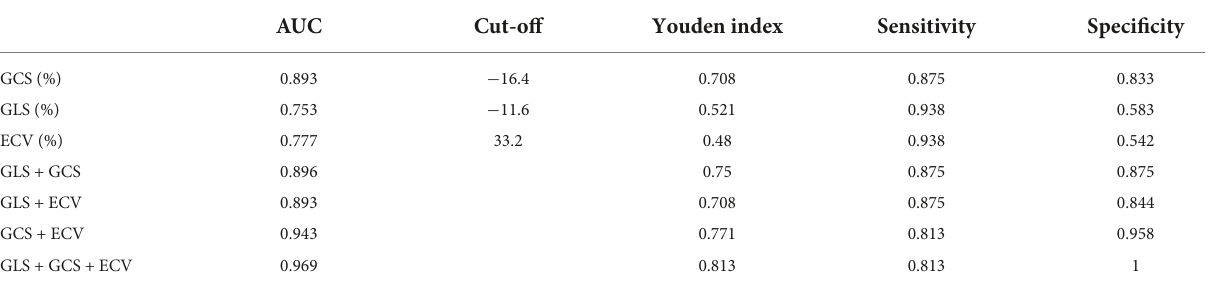
TABLE 5 The diagnostic value of cardiovascular magnetic resonance to differentiate between Mayo stage I/II AL CA and HCM patients. Multi-parameters of CMR for differentiating between Mayo stage I/II AL CA patients and HCM